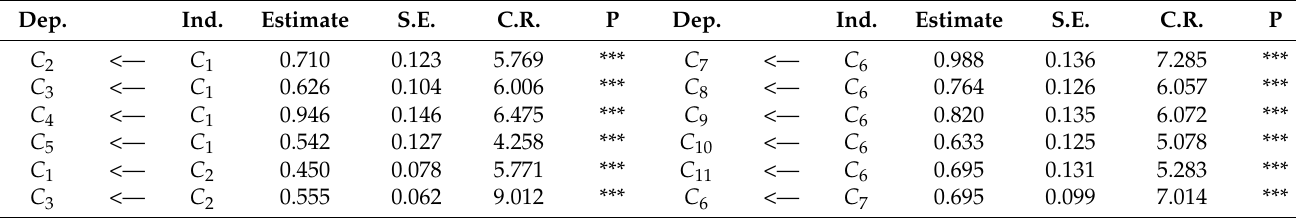
Table A3. The direct influences of criteria.